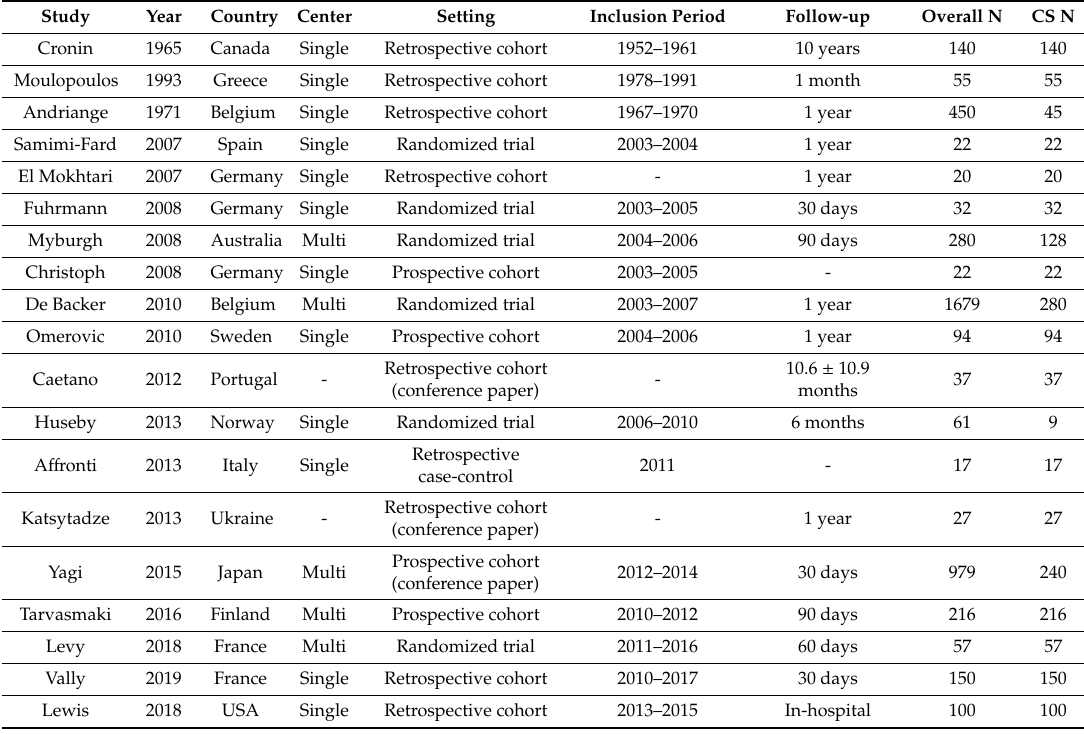
Table 1. Summary of included studies ( n = 19) on inotrope / vasopressor therapy in cardiogenic